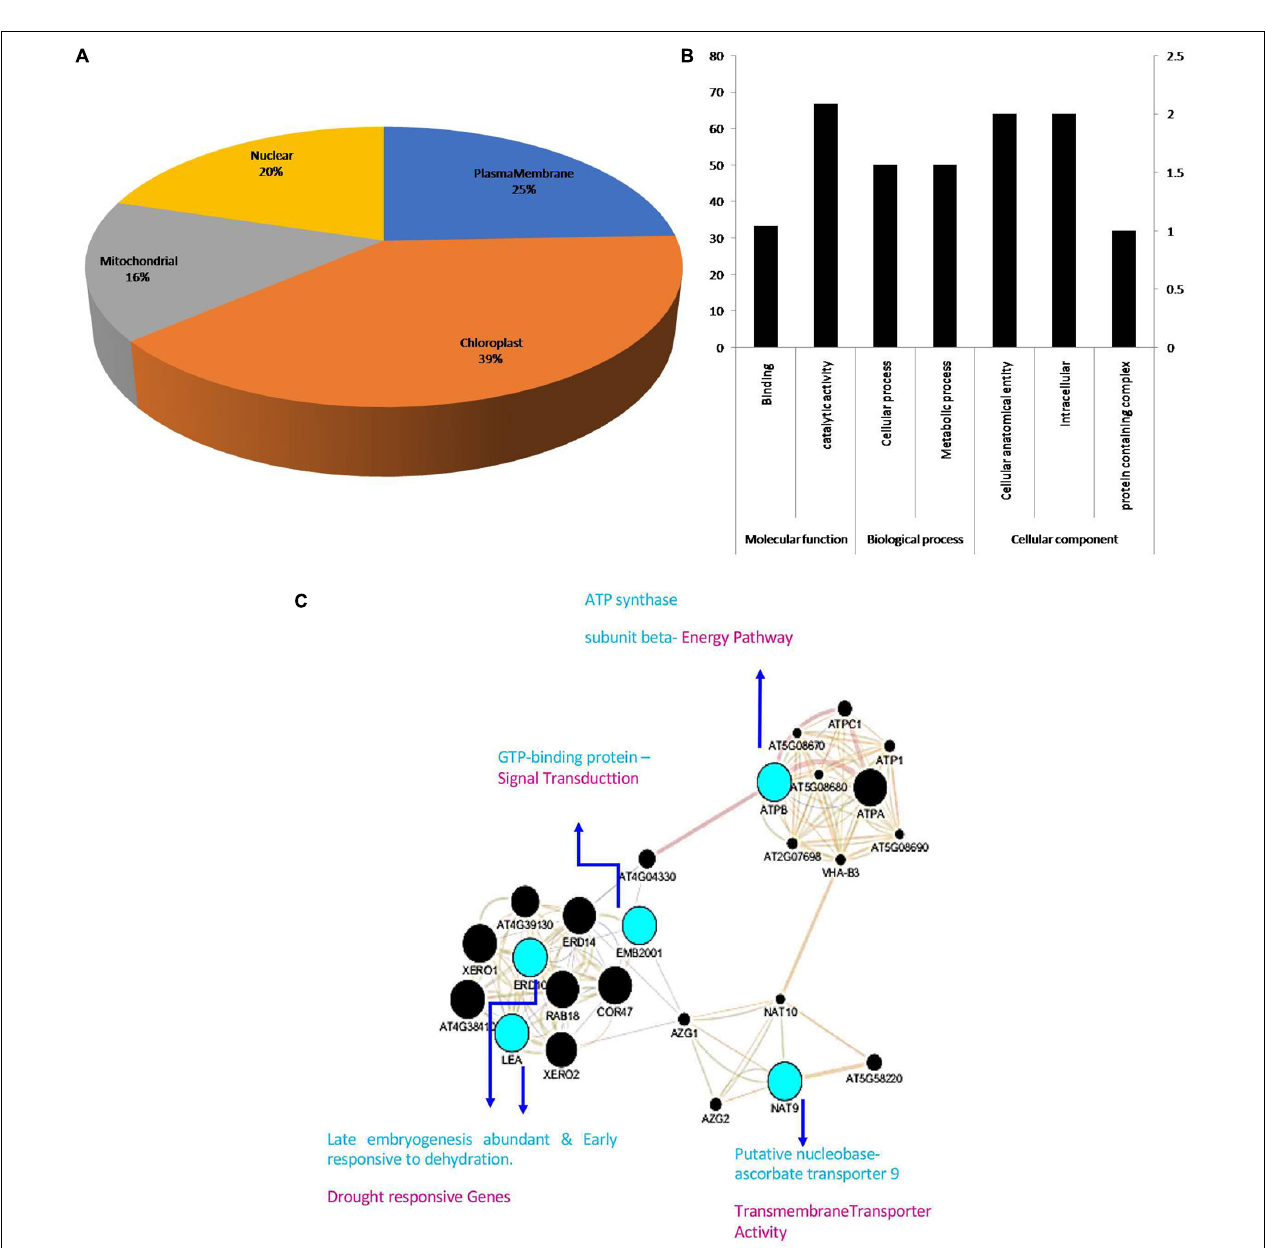
FIGURE 5 | (A) The subcellular locations of the identified proteins. (B) GO classification of the identified DEPs. To reveal the functions of the identified eight DEPs between Bt and Non-Bt, GO functional analysis was carried out using Panther classification system software. The identified eight DEPs were classified into three main categories including cellular component, biological process, and molecular function with seven subgroups. The number of genes signifies that of proteins with GO annotations. (C) Interactions of these differentially accumulated proteins are extracted using the app GeneMANIA from